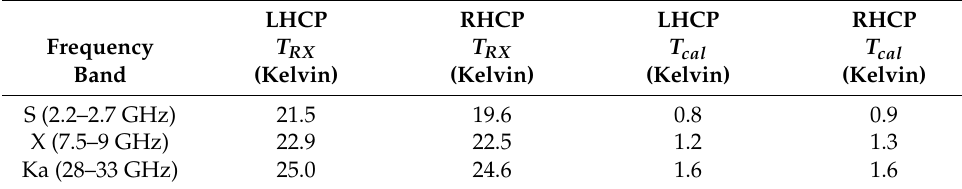
Table 5. Average noise and calibration temperatures for Ishioka